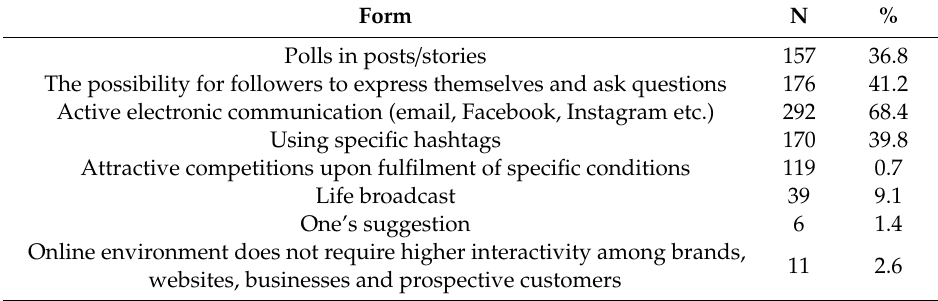
Table 5. Recommended forms of interactivity of sustainable businesses in the online environment. Form N %